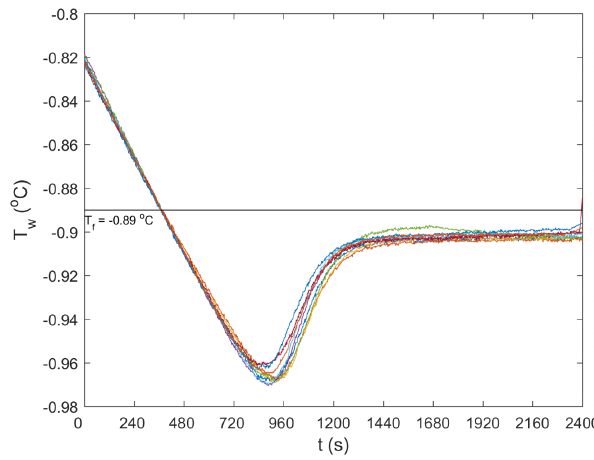
Figure 3. Superimposed supercooling curves from repeated exper- iments showing water temperature, T w ( ◦ C), as a function of time, t (s), for a salinity of 15‰. The different curves represent repeated experiments, and the freezing temperature T f ( ◦ C) is indicated by the horizontal